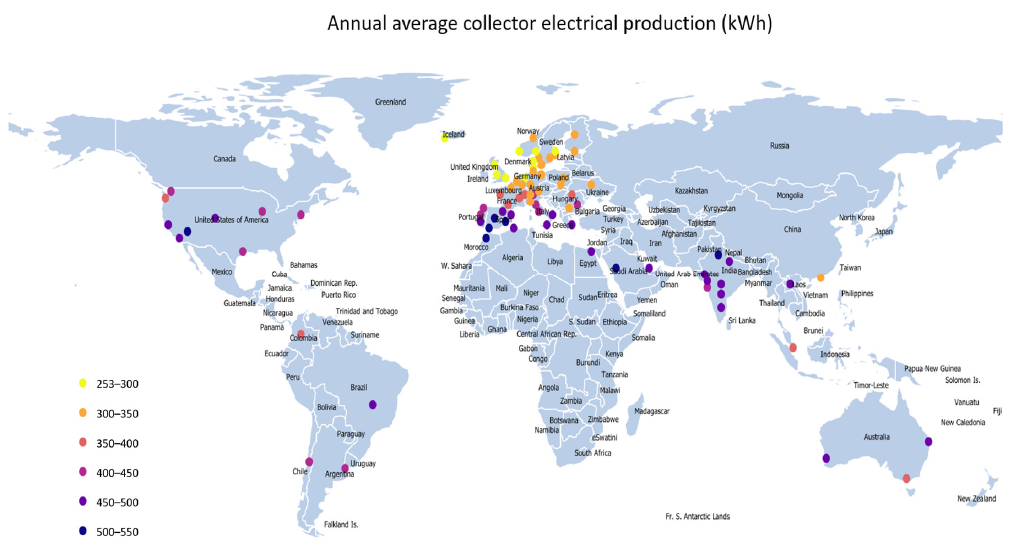
Buildings 2020 , 10 , x FOR PEER REVIEW Figure 9. Annual average collector electrical performance. Figure 9. Annual average collector electrical performance.